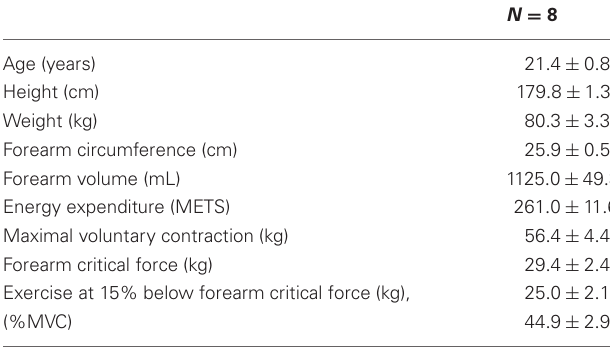
Table 1 | Subject